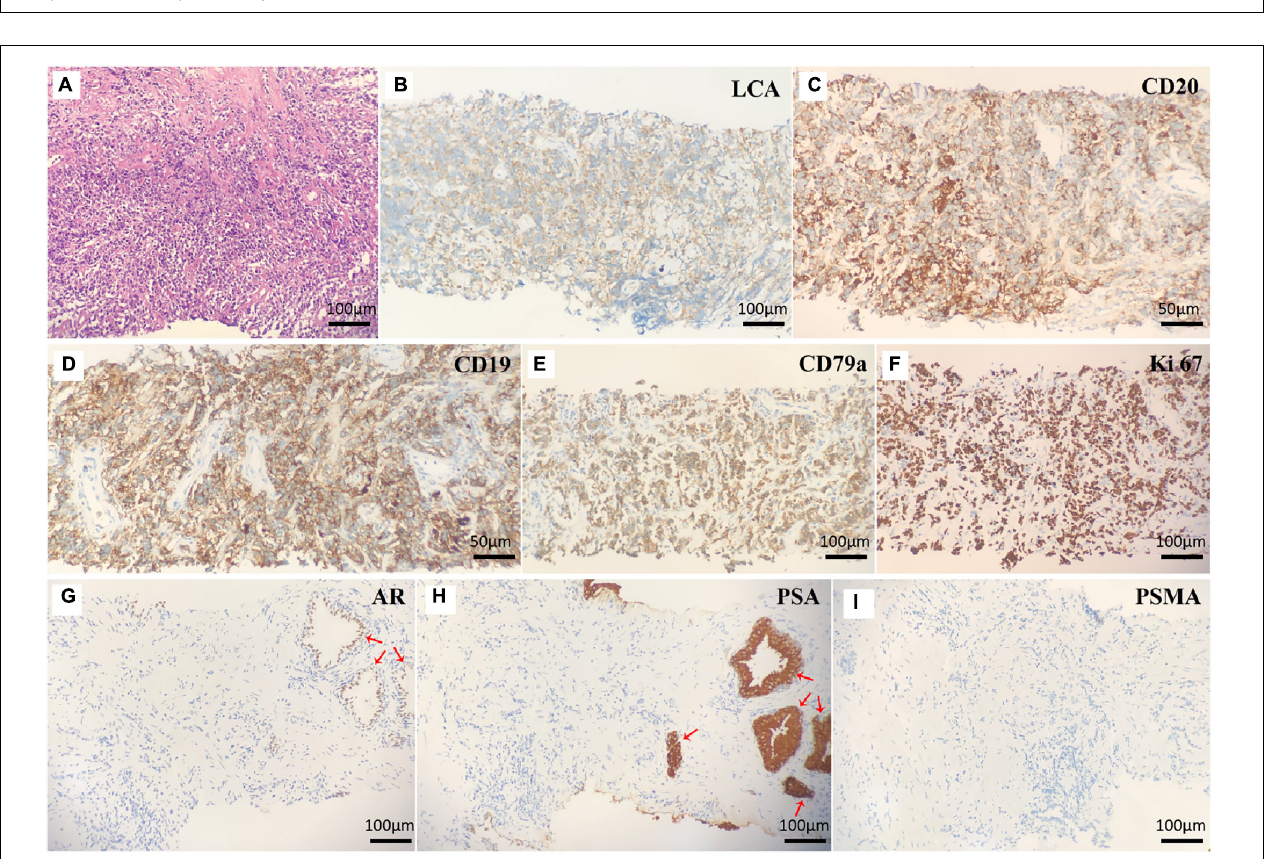
FIGURE 2 | (A) Hematoxylin and eosin staining of prostate lesions showed diffuse large B-cell lymphoma. The eight micrographs illustrate (B) LCA + , (C) CD20 + , (D) CD19 + , (E) CD79a + , (F) Ki-67 + , (G) AR − , (H) PSA − , and (I) PSMA − tumor cells. Normal prostate cells were positive for AR (G) and PSA (H) (red arrow).